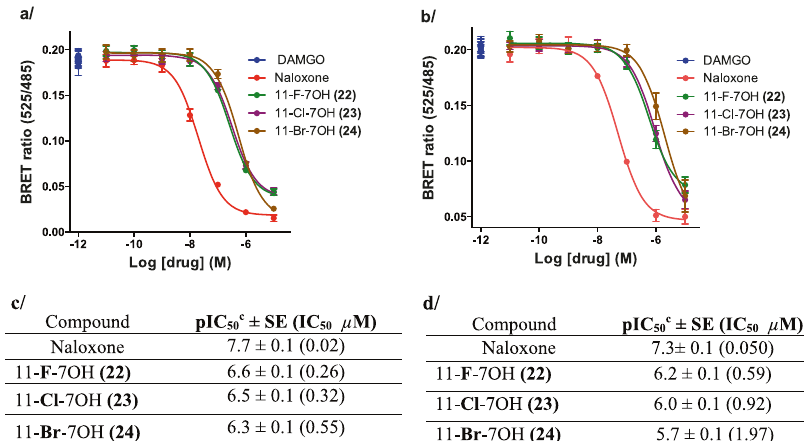
Fig. 8 Antagonist activity of 7OH analogs at mMOR and hMOR. To assay G protein activation, mMOR and hMOR was coexpressed with G protein subunits G α oB , β 1 , γ 2 , and the BRET CAMYEL sensor. Antagonism was measured by the inhibition of DAMGO ’ s effect on cAMP. a Competitive antagonist activity of 7OH analogs at mMOR; positive control = naloxone. b Competitive antagonist activity of 7OH analogs at hMOR; positive control = naloxone. Curves represent the average of n = 3, independent experiments with error bars representing ±SEM. c Functional antagonist activity of 7OH analogs at mMOR as determined in CAMYEL BRET assays. d Functional antagonist activity of 7OH analogs at hMOR as determined in CAMYEL BRET assays [ c Antagonist activity indicated by IC 50 values for inhibition of a reference agonist (DAMGO), all data points represent − logIC 50 ± SE (IC 50 µ M) for n = 3